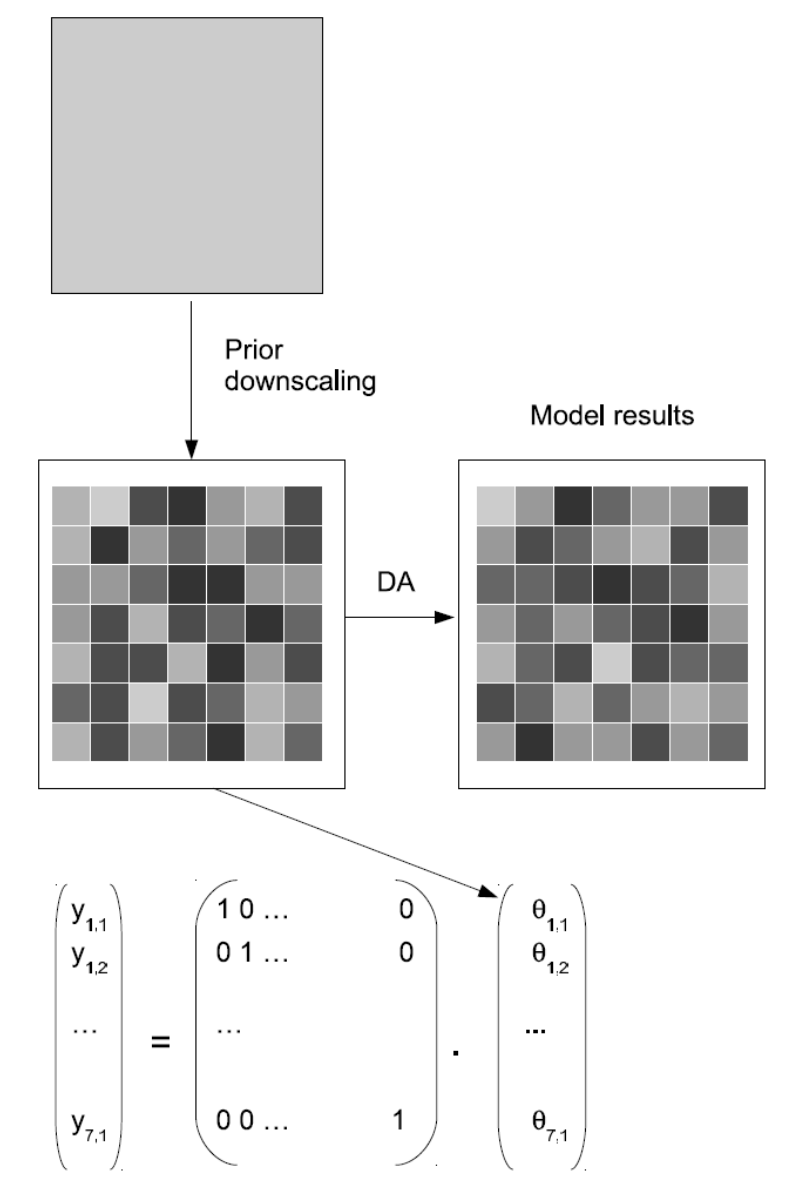
Figure 4. Schematic of the use of prior downscaling for the assimilation of coarse-scale data into a fine-resolution model for a model with only one model layer. The symbols are identical to those in Figure 3. As in Figure 3, the . (cid:2879) is omitted from the y and θ variables, and the time index k is omitted from all variables. DA refers to data